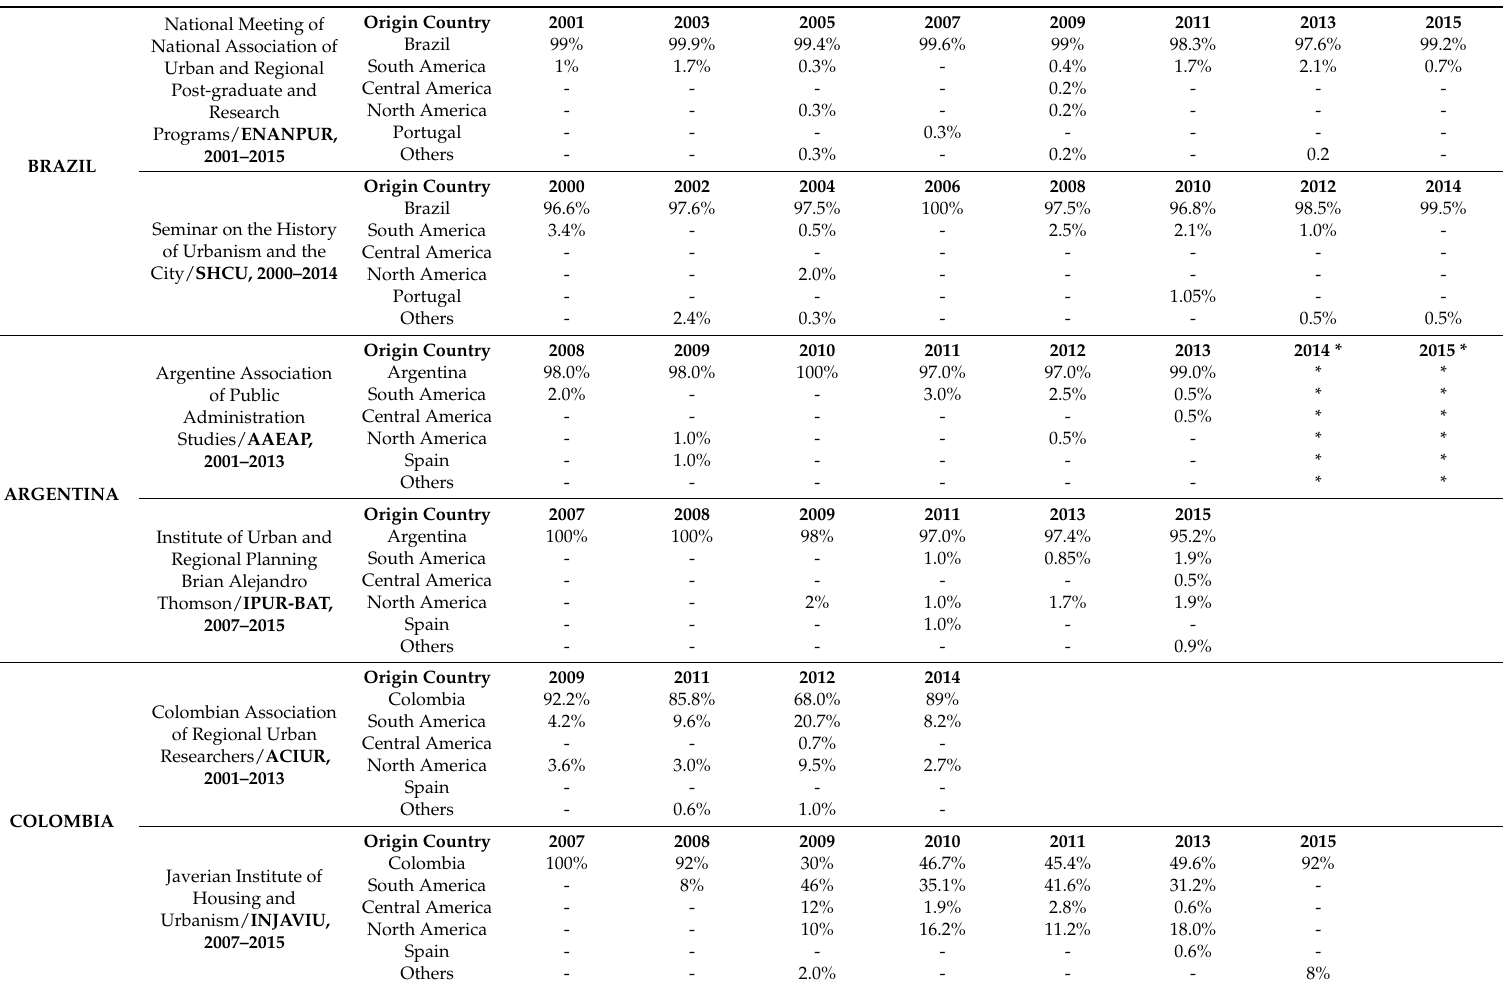
Table 4. Country of origin of authors in selected scientific events in selected countries of Latin America.